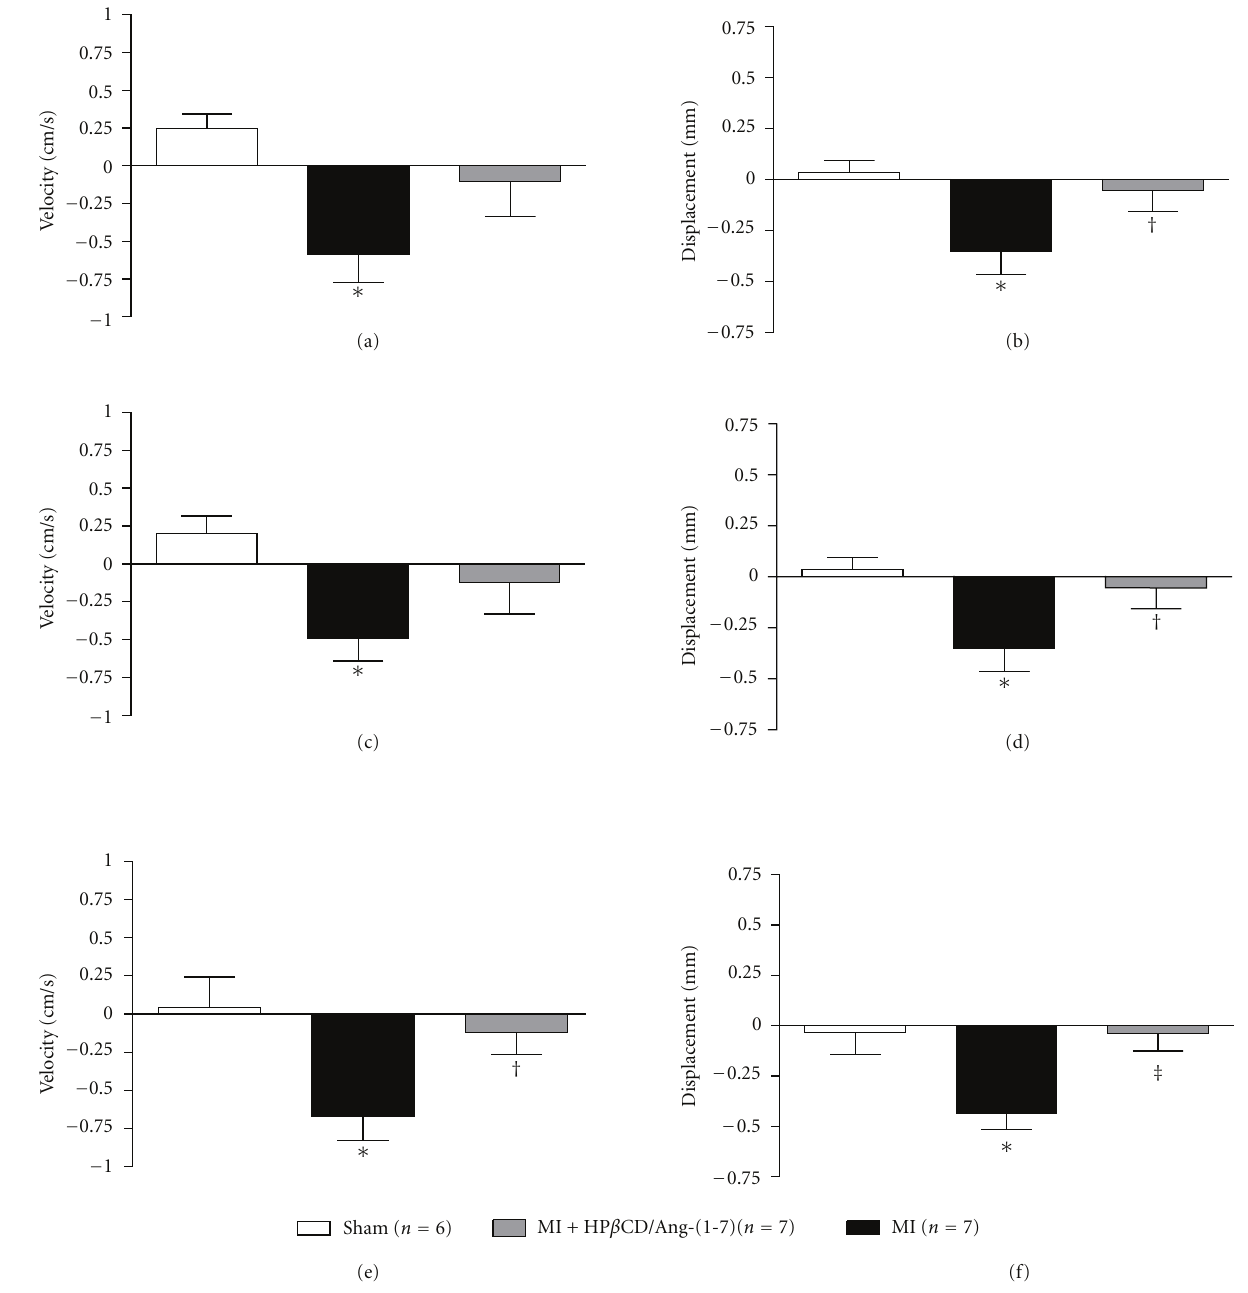
Figure 3: E ff ects of HP β CD/Ang-(1–7) on the variation of the velocity and displacement in rats after (a and b) 15 days; (c and d) 30 days, and (e and f) 50 days of treatment. ∗ P < 0 . 05 versus sham; † P < 0 . 05 versus MI; ‡ P < 0 . 01 versus MI (one-way ANOVA followed by the Newman-Keuls